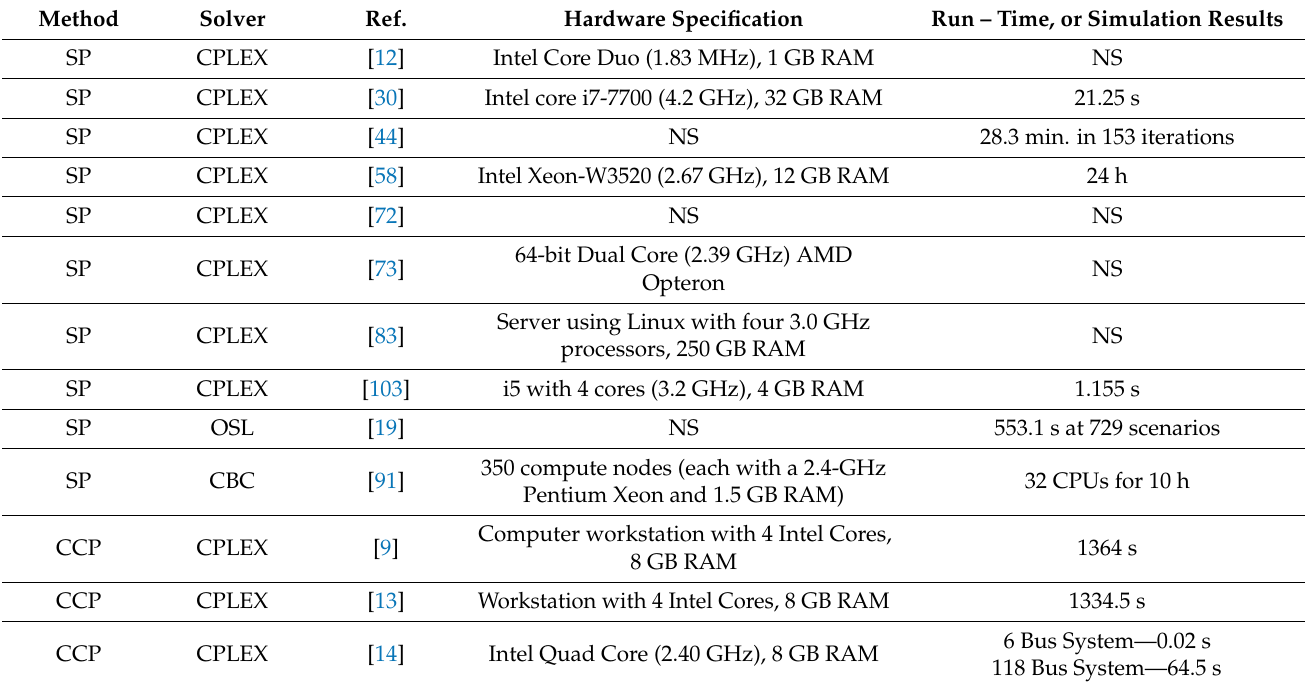
Table 18. Summaries Regarding Methods, Hardware Specification, Run – time And Simulation